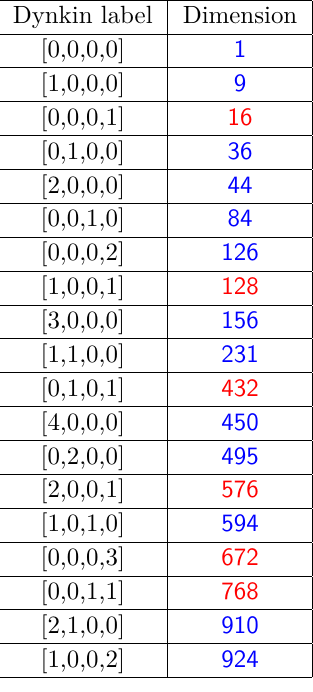
Table 2 . so (9) irreducible representations #1 [9].